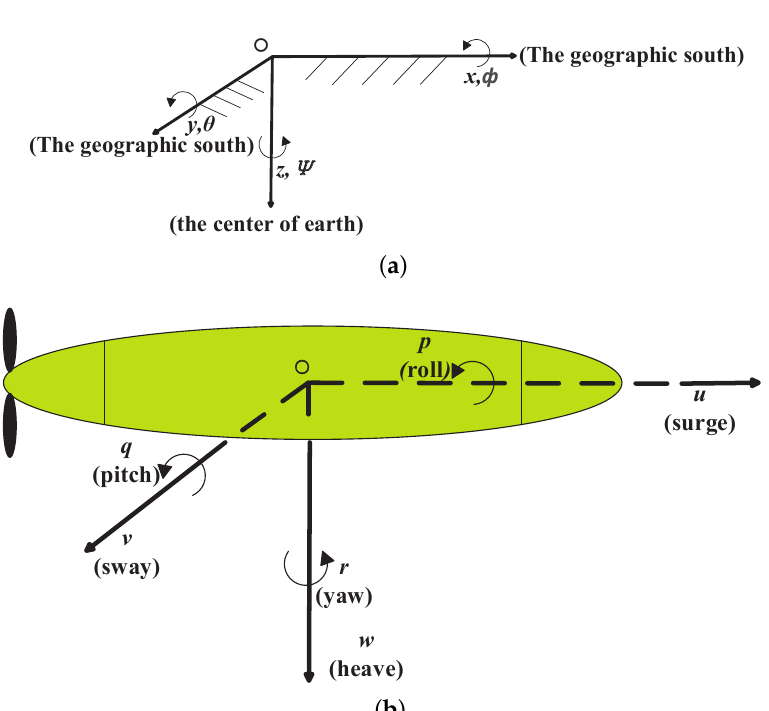
Figure 1. AUV 3D position tracking reference frames: ( a ) earth-fixed frame and ( b ) body-fixed